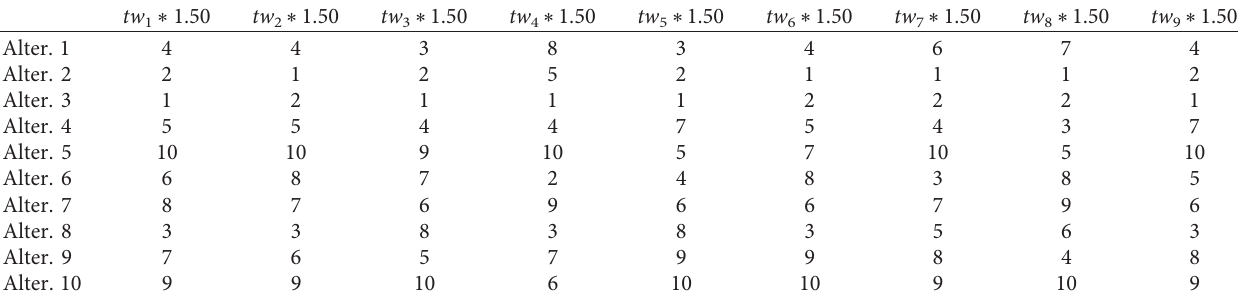
Table 26: Scenarios for the sensitivity analysis (phase I, 50%).